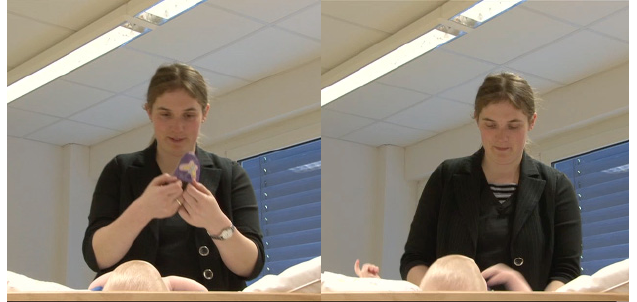
Figure 3. A mother announcing her next action that is performed on the infant.